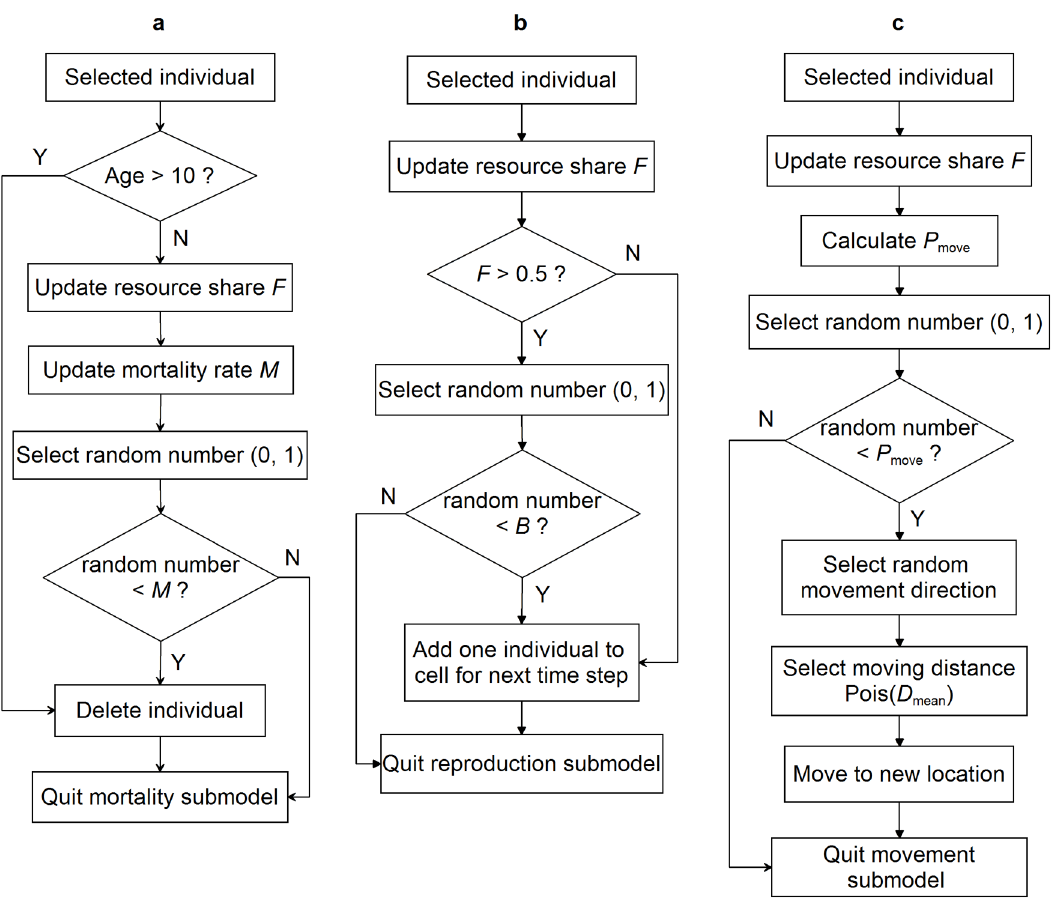
doi:10.1371/journal.pone.0107742.g002